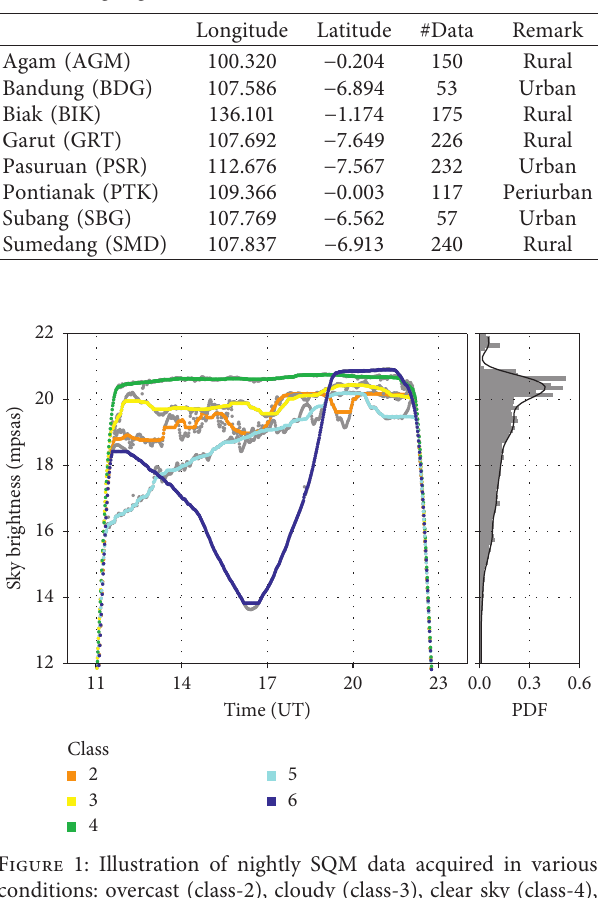
Table 1: Locations of the sky brightness measurements conducted from April to December 2018. The fourth column lists the number of observing nights.